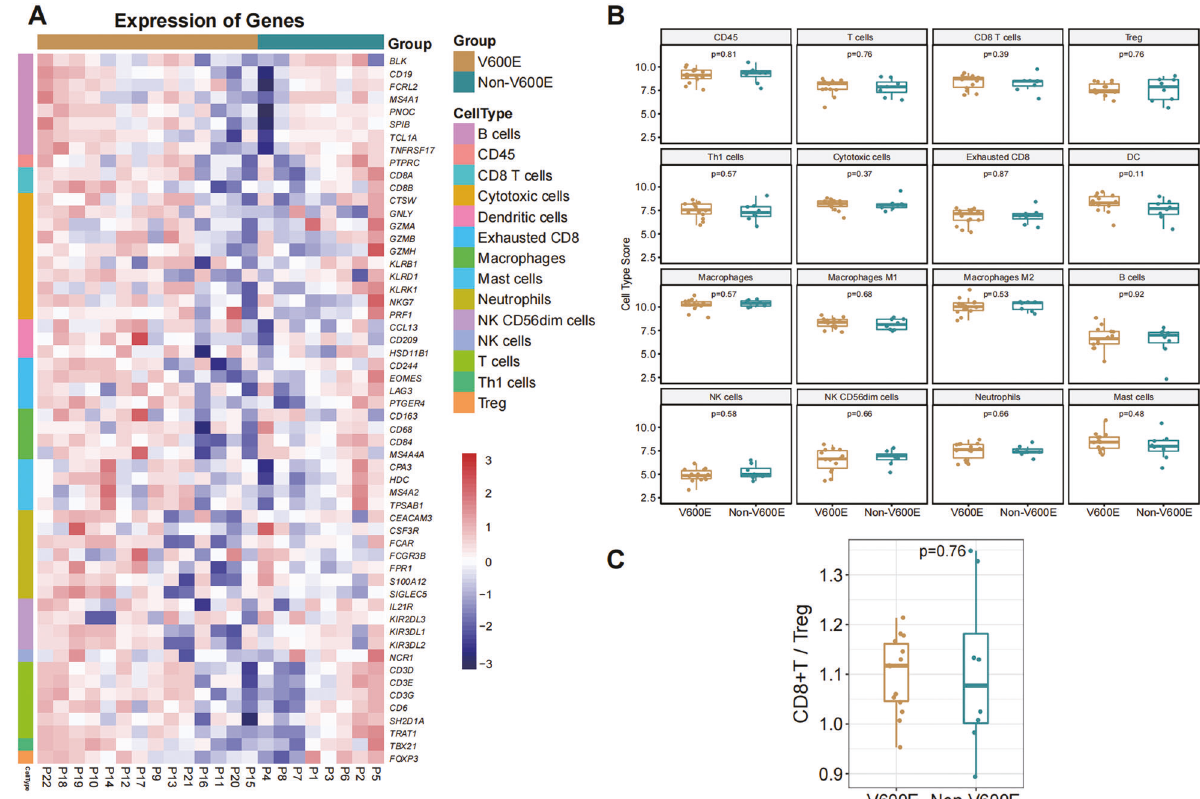
Fig. 2 The immune cell scores in both BRAF V600E and Non-V600E NSCLC. A Heatmap of gene transcripts related to various subsets of immune cells in the BRAF V600E and Non-V600E NSCLC specimens. B Quantitative analysis of immune cell scores in the BRAF V600E and Non- V600E NSCLC specimens. C The ratios of CD8 T cells to Tregs in the BRAF V600E and Non-V600E NSCLC